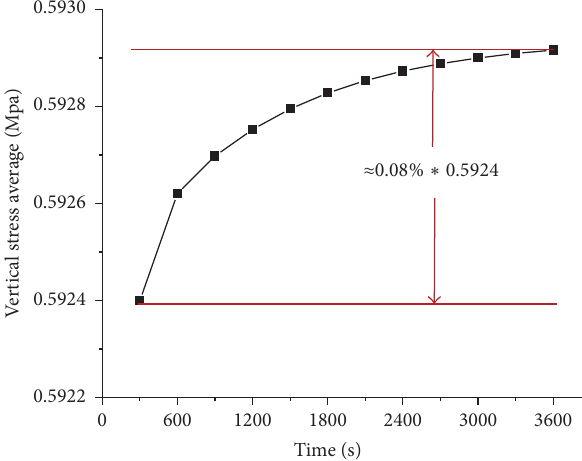
Figure 8: Time history of mean values of the vertical